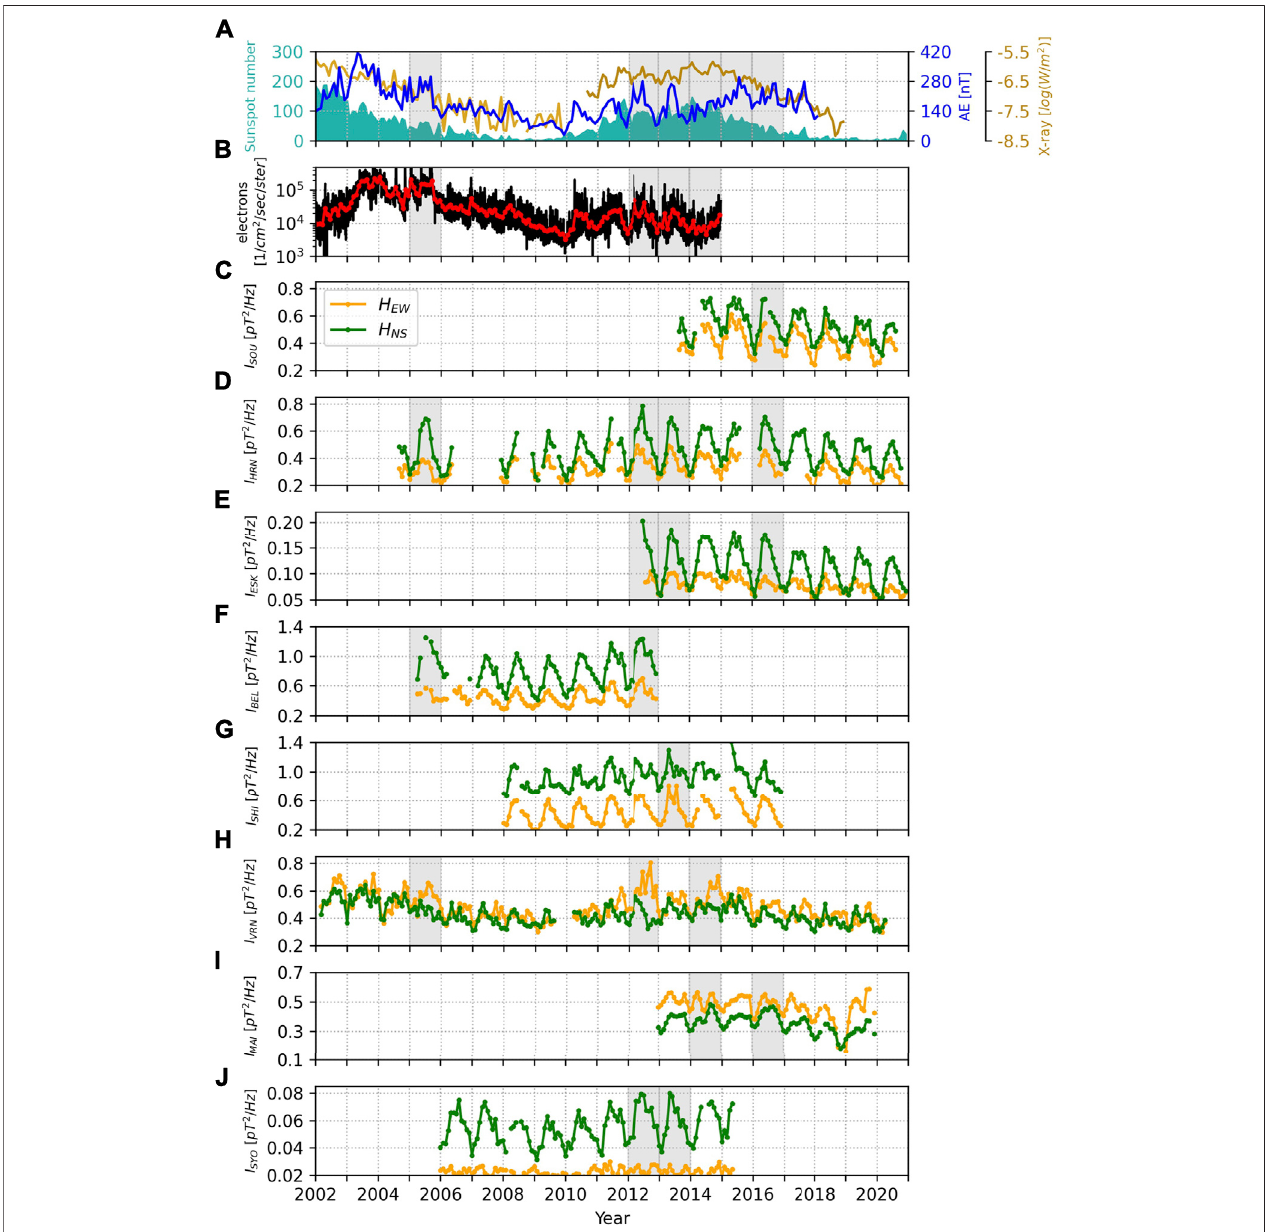
FIGURE 3 | (A) Monthly average values of the sunspot number (turquoise), the AE index (blue) and the X-ray fl ux (GOES-10: gold, GOES-15: dark gold), (B) 30 – 300 keV electron precipitation fl uxes in daily (black) and monthly (red) time resolution as well as the long-term recordsof the fi rst SR mode ’ s intensity in monthly time resolution at the (C) Sousy (SOU), (D) Hornsund (HRN), (E) Eskdalemuir (ESK), (F) Belsk (BEL), (G) Shillong (SHI), (H) Vernadsky (VRN), (I) Maitri (MAI) and (J) Syowa (SYO) SR stations. Gray background highlights years with exceptional SR intensities.